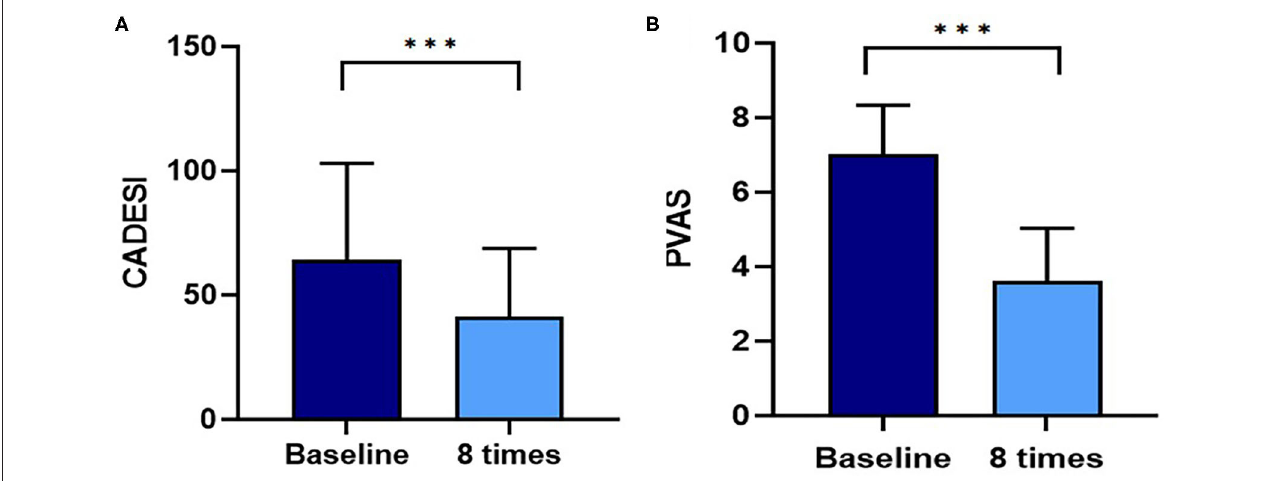
FIGURE 3 | Assessment of the CADESI and PVAS with excimer light therapy. (A) Change in the CADESI with excimer light therapy. (B) Change in the PVAS with excimer light therapy. Eight times, end of the excimer light therapy in allergic group; baseline, before start of excimer light therapy in allergic group. CADESI, canine atopic dermatitis extent and severity index; PVAS, Pruritus Visual Analog Scale. All values are expressed as mean ± standard error. *** P < 0.001.